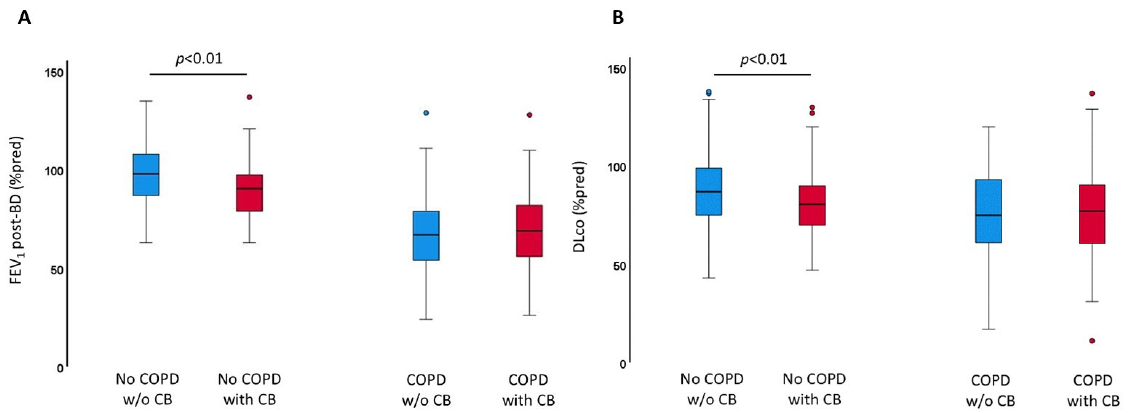
Figure 1. ( A,B ). Effects of Chronic Bronchitis (CB) on FEV 1 and diffusion capacity (DLco). ( A ) CB worsens the FEV 1 (%pred) ( p < 0.01) and ( B ) DLco (%pred) ( p < 0.01) in smokers with no COPD, but not in smokers with COPD. Bottom and top of each box plot: 25th and 75th percentiles; solid line: median; brackets: 10th and 90th percentiles. CB: Chronic Bronchitis; COPD: Chronic Obstructive Pulmonary Disease; FEV 1 : forced expiratory volume in the first second; DLco: diffusing capacity of the lung for carbon monoxide.